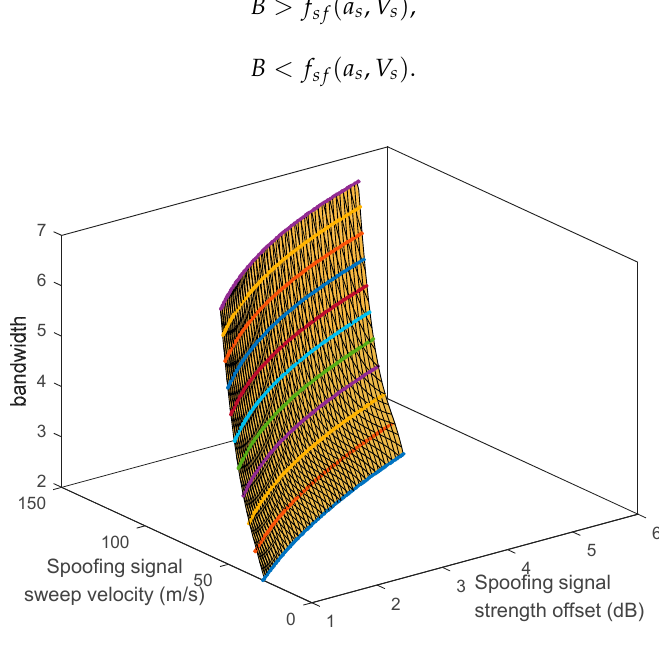
Figure 18. Boundary lines according to the DLL bandwidth ( a ) boundary lines in two dimension; ( b ) boundary lines in three dimension.